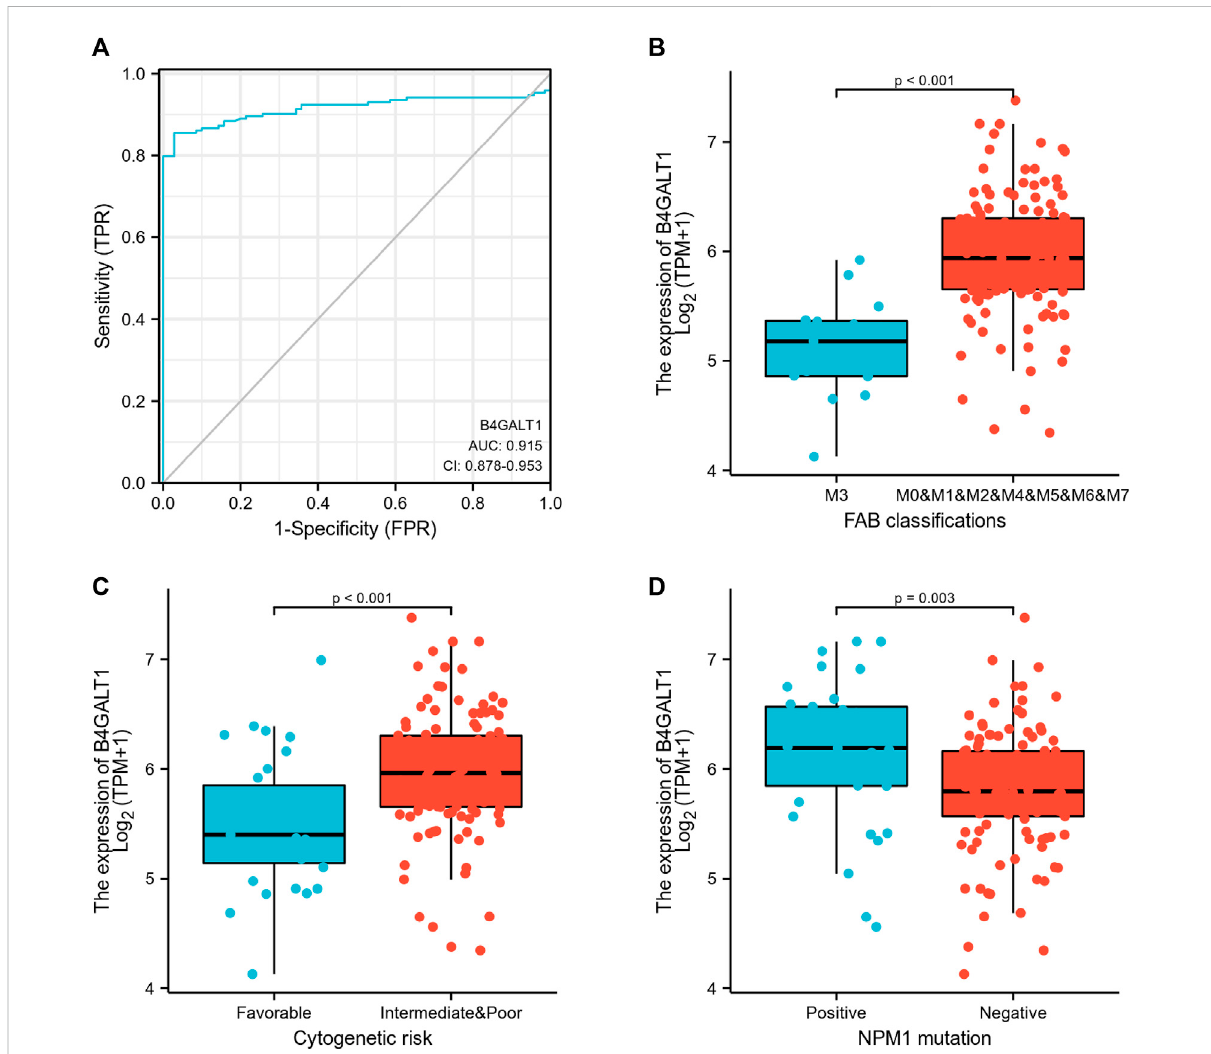
FIGURE 2 Association between B4GALT1 expression and clinical features. (A) ROC analysis of B4GALT1 shows promising discrimination power between tumor and normal tissues. (B) FAB classi fi cation; (C) cytogenetics risk; (D) NPM1